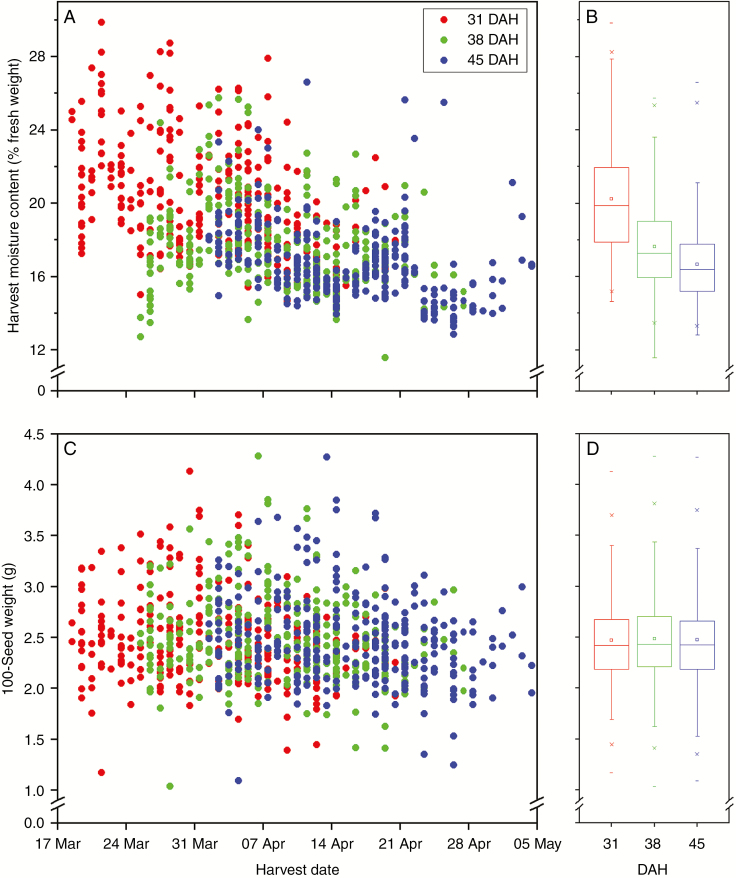
Changes in seed harvest moisture content (MC) and 100-seed weight over the harvesting period for 299 Indica rice accessions. Seeds were harvested at 31, 38 and 45 days after heading (DAH). Panels (B) and (D) are box plots of the data shown in (A) and (C), to summarize the changes in harvest MC and 100-seed weight for the different harvests. In (B) and (D) the square symbol is the mean, the box spans the 25th and 75th percentiles, the whiskers represent the 5th and 95th percentiles, the crosses the 1st and 99th percentiles, and the dashes the minimum and maximum values, respectively.